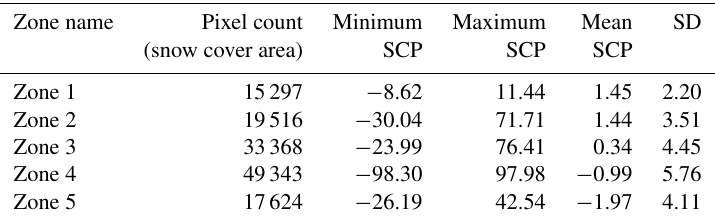
Table 4. The zonal changes in snow cover (in percent) derived from the linear fit (LIN). Note: SCP is the snow cover percentage; SD is the standard deviation.